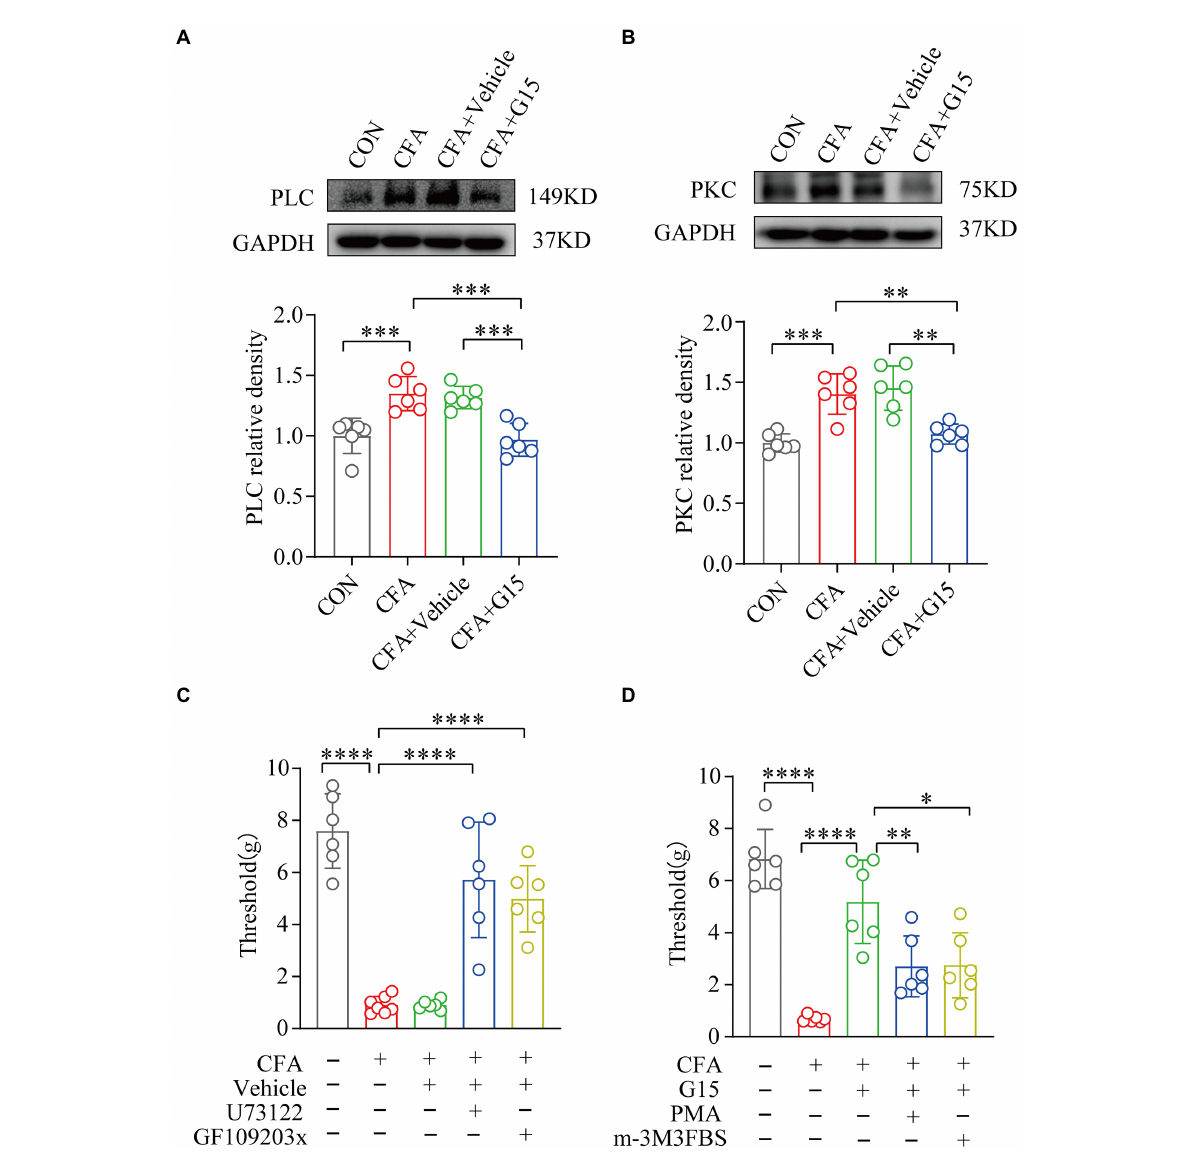
FIGURE 8 G15 alleviated CFA-induced pain through the PLC-PKC signaling pathway. (A, B) WB detection of PLC and PKC expression in RVM. The levels of these proteins were significantly different in both the CON and CFA + G15 groups compared with the CFA group. There was no significant difference between the CFA group and CFA + Vehicle group. (C) Treatment with GF109203x and U73122 significantly reversed the effect of G15 compared with the CFA + G15 group. There was no significant difference compared with the G15 + Vehilce group. (D) Treatment with m-3M3FBS and PMA significantly increased orofacial pain thresholds compared with the CFA group, with no significant difference compared with the CFA + Vehicle group. All statistical analysis were performed using one-way ANOVA followed by the Tukey post hoc test for multiple group comparisons. * p < 0.05, ** p < 0.01, *** p < 0.001, **** p < 0.0001. n = 6 per